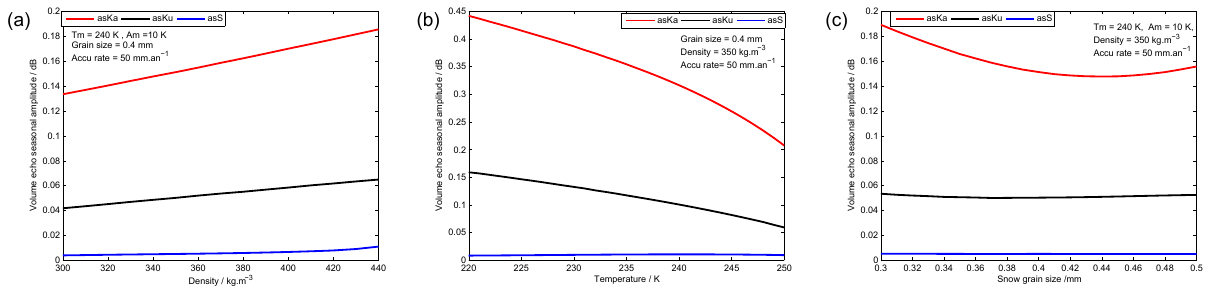
Figure 8. Sensitivity tests of the volume echo with respect to the surface snow density (a) , snow temperature (b) and snow grain size (c) at the S (blue), Ku (black) and Ka (red) bands.